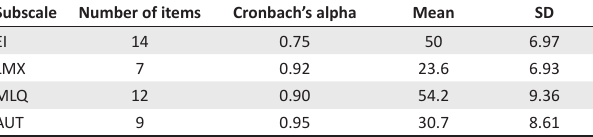
TABLE 4: Cronbach’s alpha results on sections of the questionnaire. Subscale Number of items